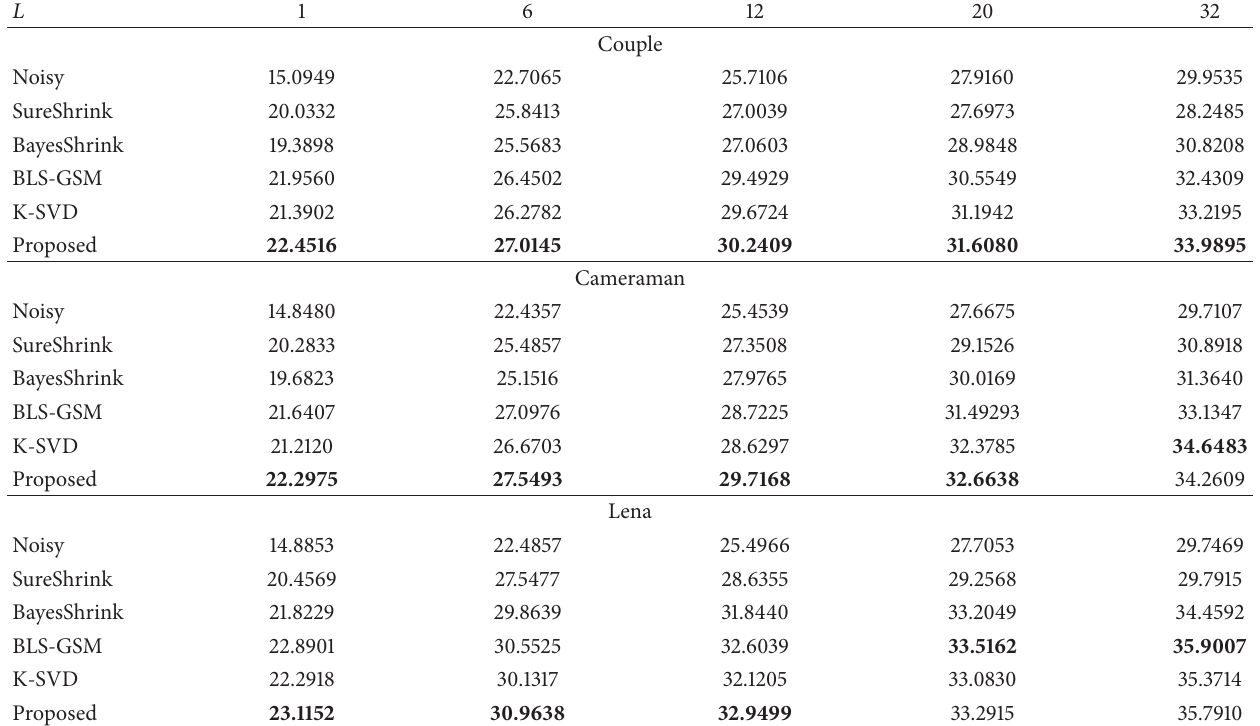
Table 4: PSNR comparison (speckle noise) of the proposed method with the other methods (in